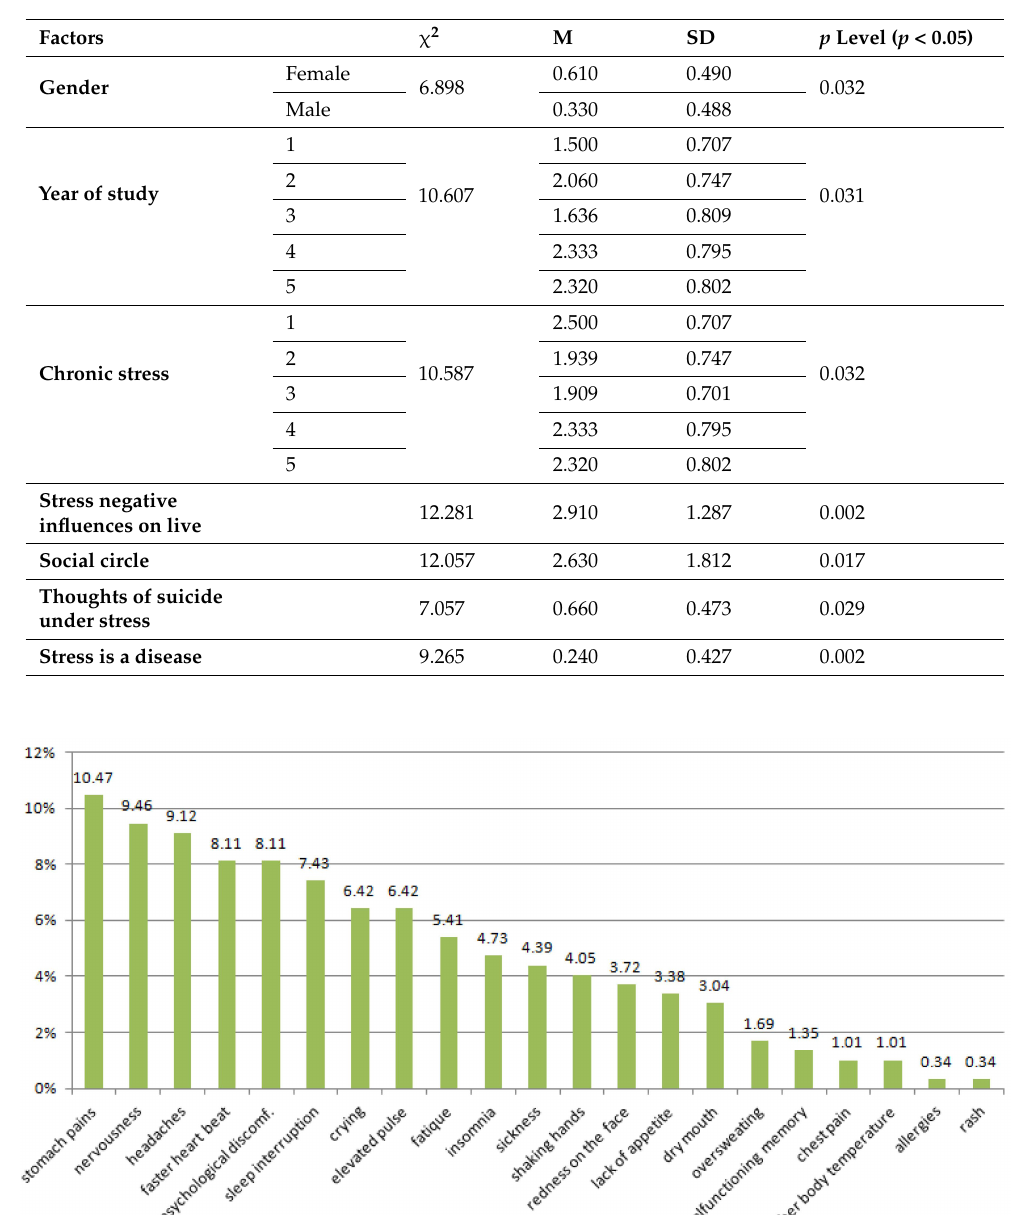
Table 3. The prevalence of stress and demographic data.